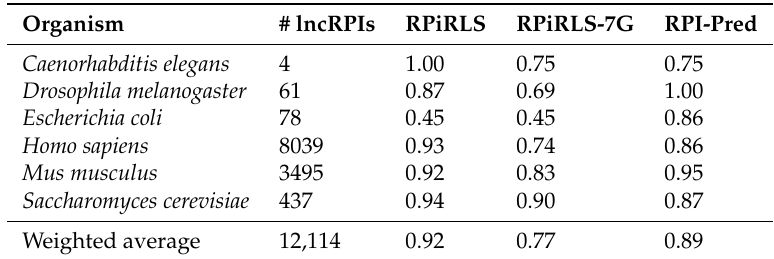
Table 7. Comparing the accuracy of RPiRLS with other methods in predicting long non-coding RNA-protein